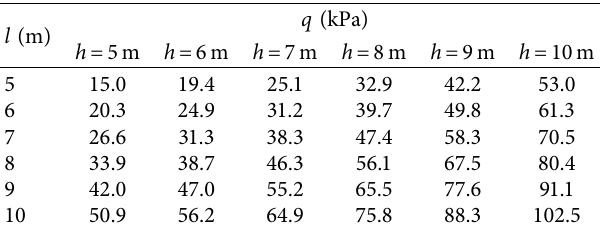
Figure 5: Effect of c and K on the surrounding rock pressure e . Table 3: Upper bound solution of the surrounding rock pressure q at different l and h .